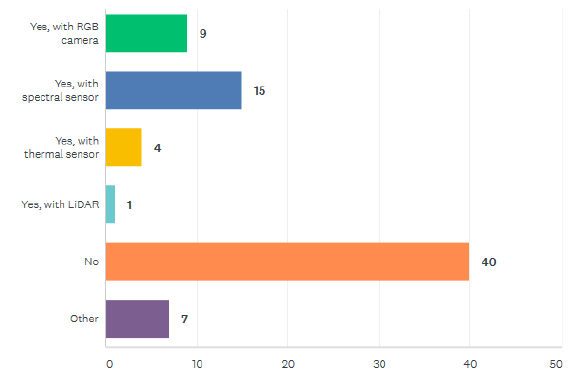
Figure 2 Are you planning to aquire a UAV in the near future?